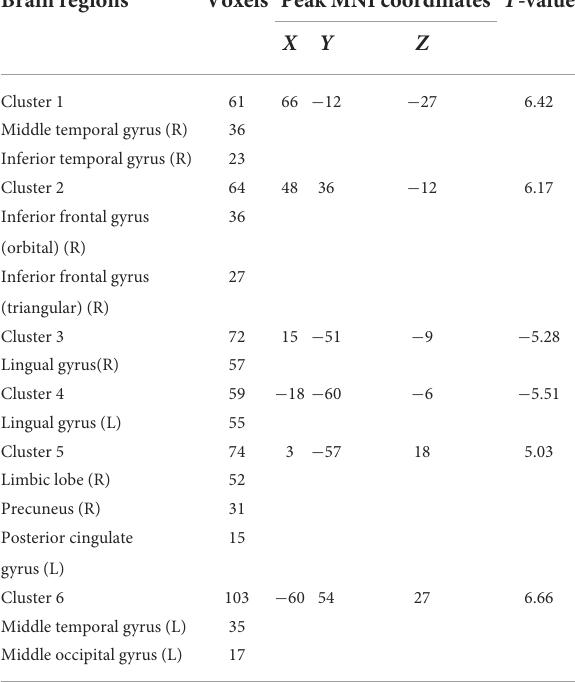
TABLE 3 Brain regions with abnormal ALFF in patients with